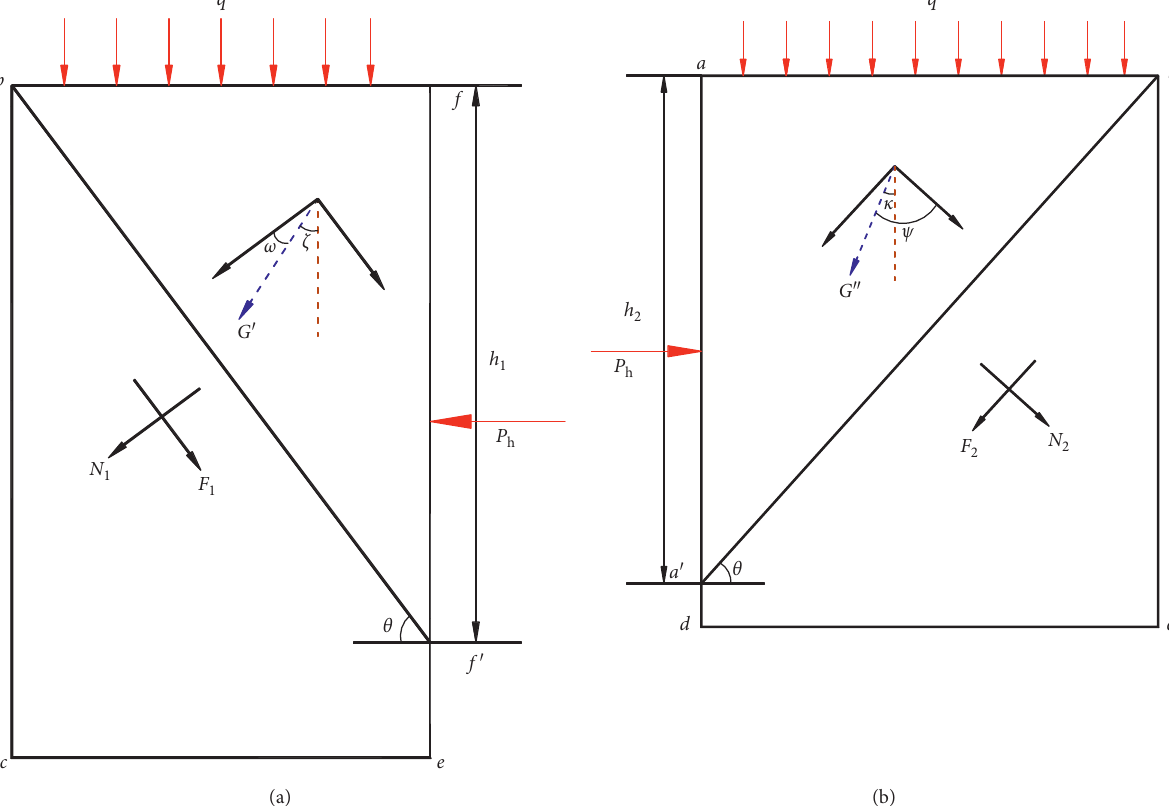
Figure 8: Analysis of shear failure of MCWS. (a) MCWS bfec ; (b) MCWS abcd